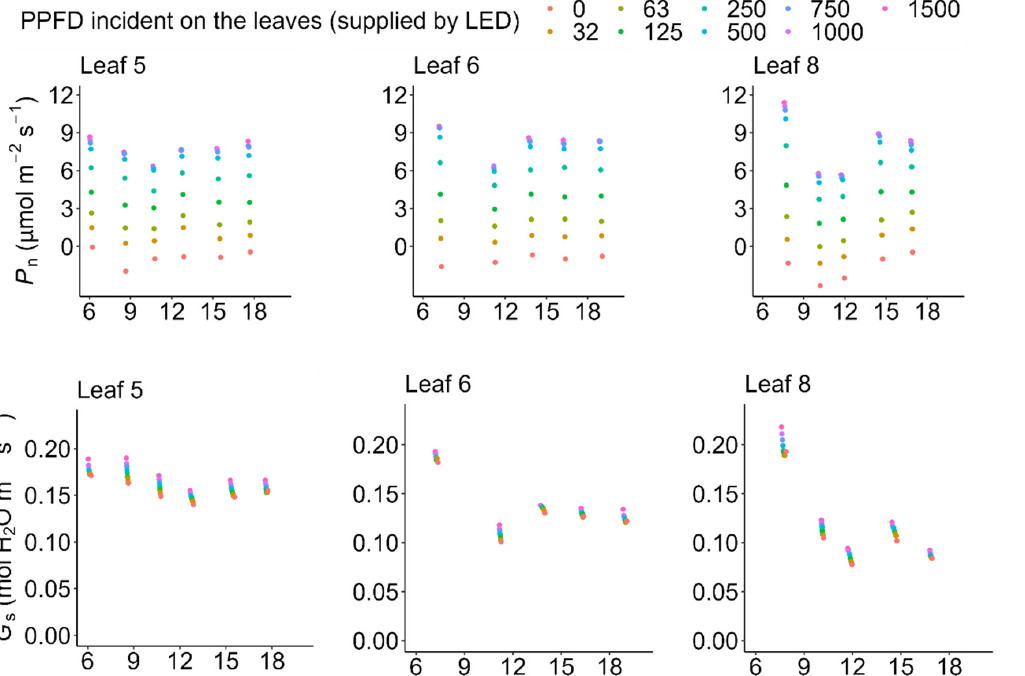
Figure 2. Diurnal courses of the light-response curves on a very hot day (19 July 2021). PPFD: pho- tosynthetic photon flux density supplied with a light-emitting diode (LED) light source (LI-6400- 02B), P n : net photosynthetic rate, G s : stomatal conductance, T r : transpiration rate, and VpdL: vapor pressure deficit based on leaflet temperature. These values were measured with an LI-6400 system. All of the data are available in the Supplementary Materials.